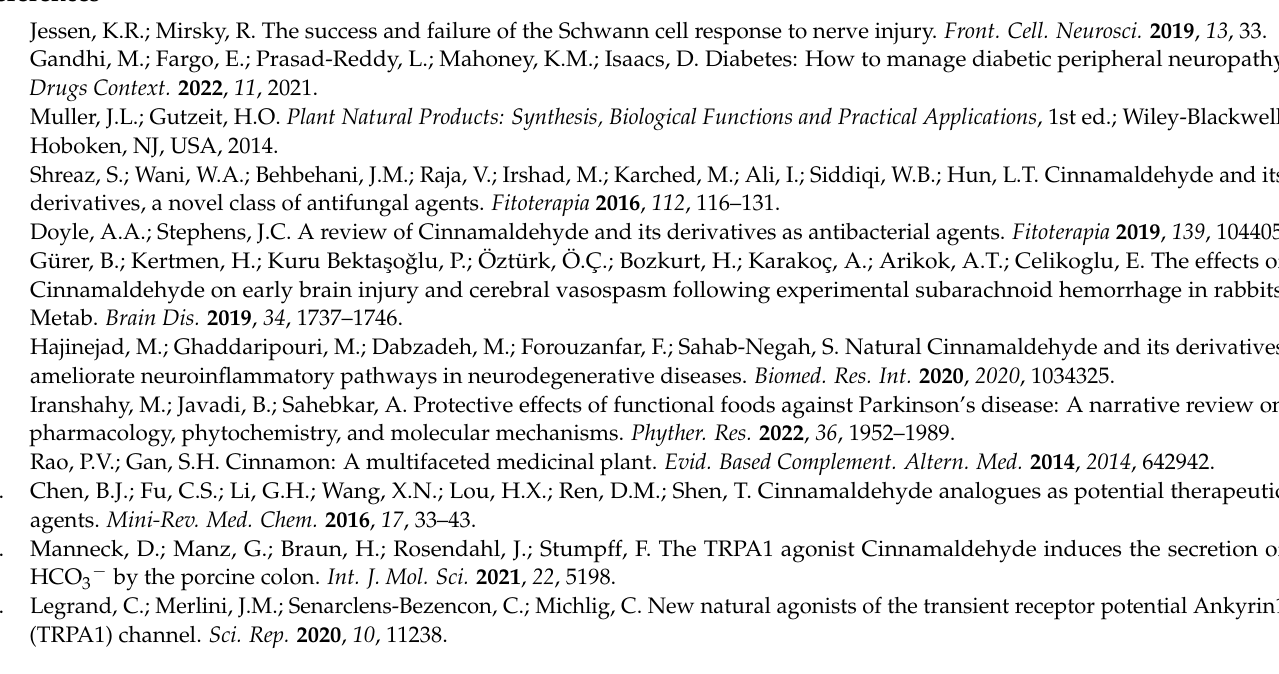
Table S2: Molecular docking between TRPA1 and CAH